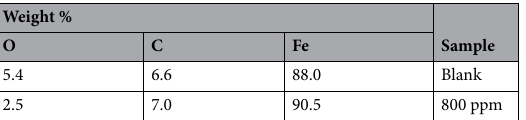
Table 4. Elemental composition of MS surface immersed in acid media and the acidic solution containing 800 ppm FV extract for 6